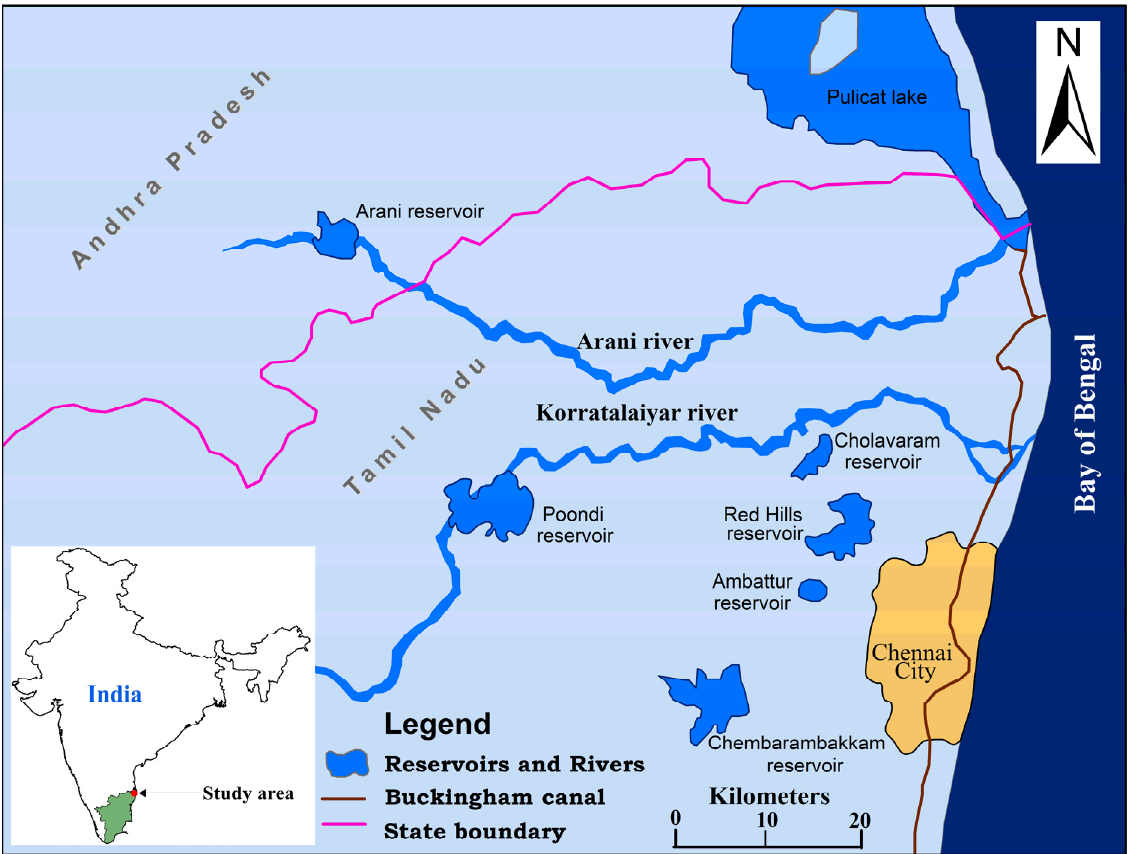
Figure 1. Reservoirs around